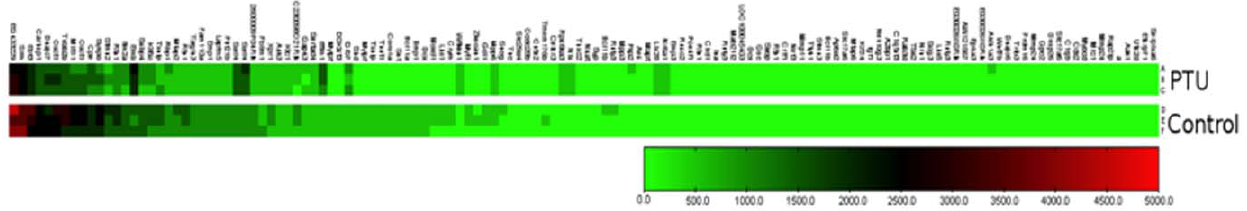
Figure 3. Heat map showing the differential gene expression of 139 genes between PTU and vehicle treated groups. Heat map generated in GenomeStudio compares the average detection signals of genes between PTU and control groups. Total RNA was collected at E10.5 from whole-embryos treated between E7.5–E9.5,. Three PTU and three control RNA samples were tested and genes with a significant p-value (p , 0.001) were displayed. Scale bar indicates detection